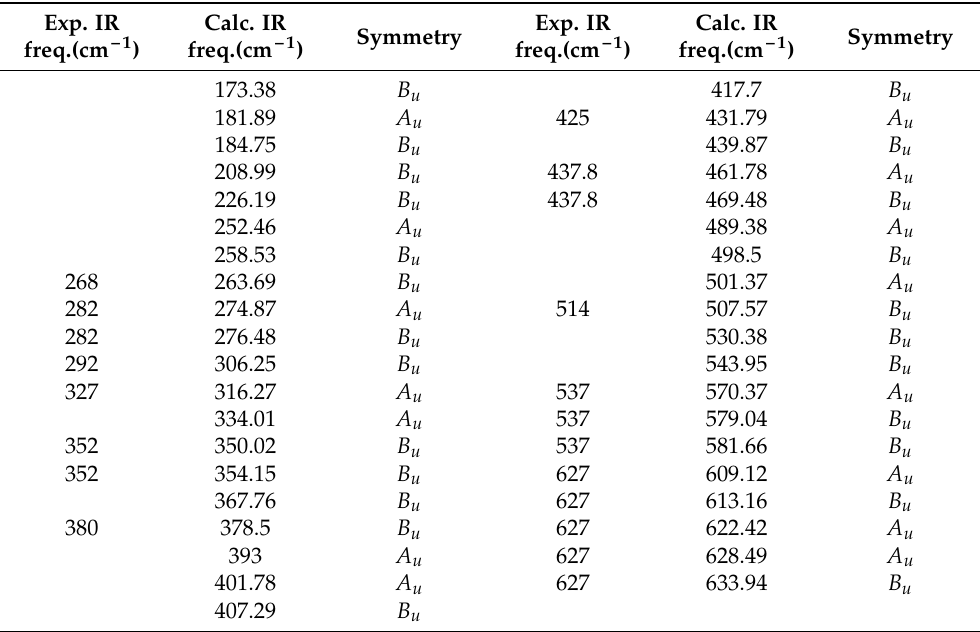
Table 2. Experimental and calculated IR modes for the Li 2 MnO 3 crystal determined by DFPT calculations.